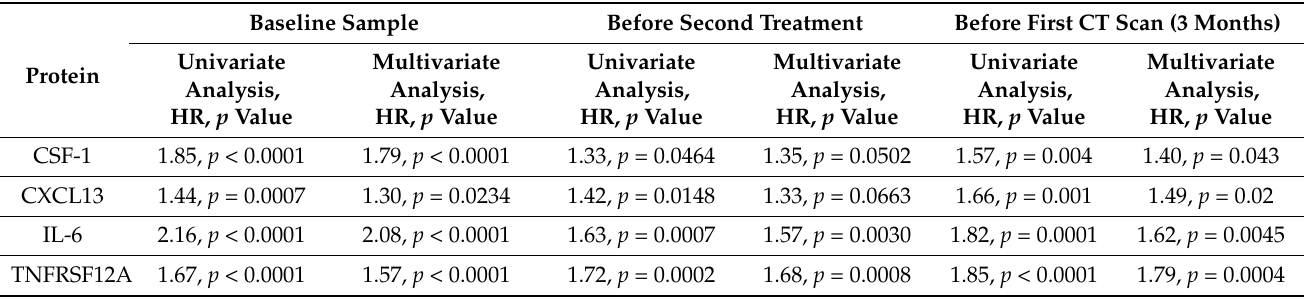
Table 4. Comparison of protein levels at different timepoints vs. OS in univariate and multivariate